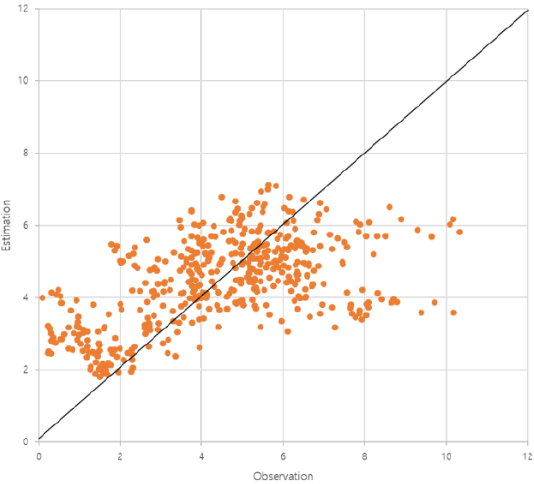
Figure 4. Scatterplot of test accuracy of MLR